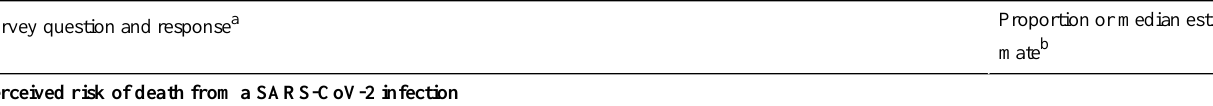
Table 2. Summary of survey